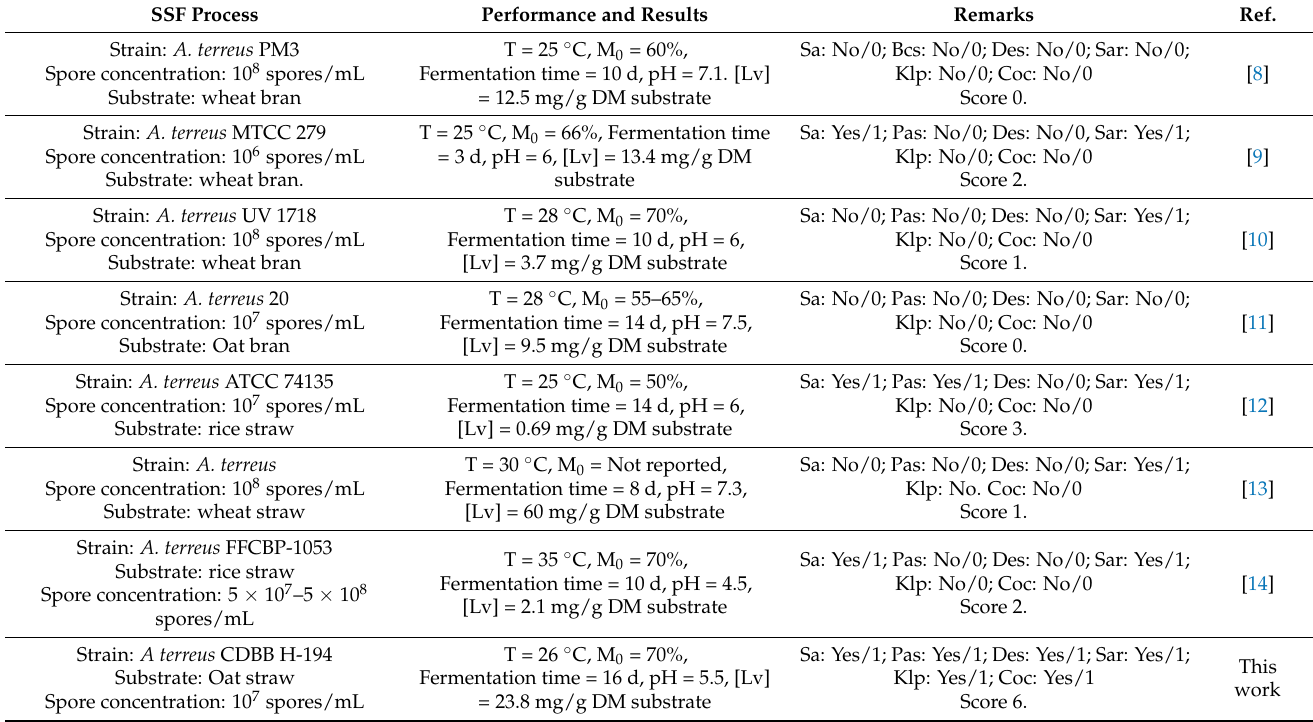
Table 1. Lovastatin production using Aspergillus strains in solid-state fermentation of agricultural residues. SSF Process Performance and Results